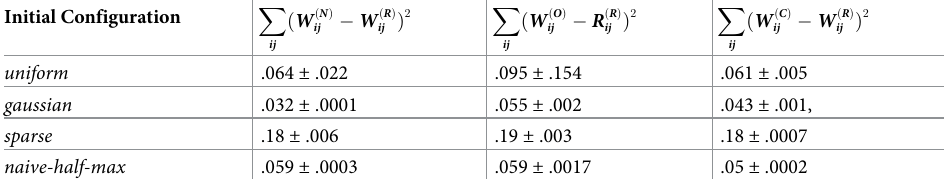
Table 6. Weight matrix differences for each initial network configuration. Mean and standard deviation reported for 30